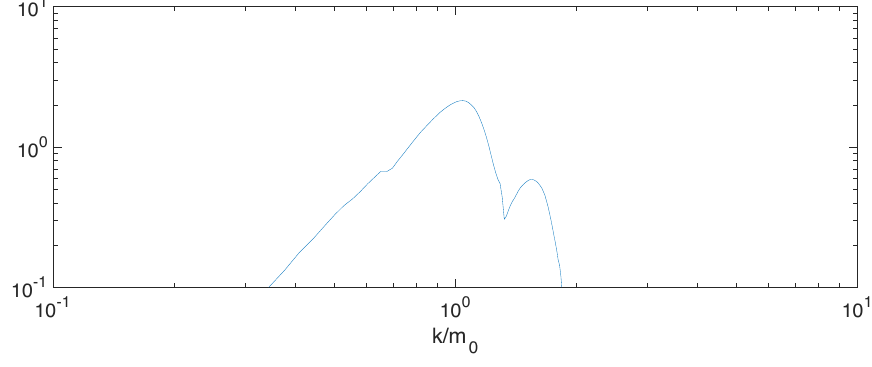
Figure 3 . A plot showing (cid:1) N ( k )